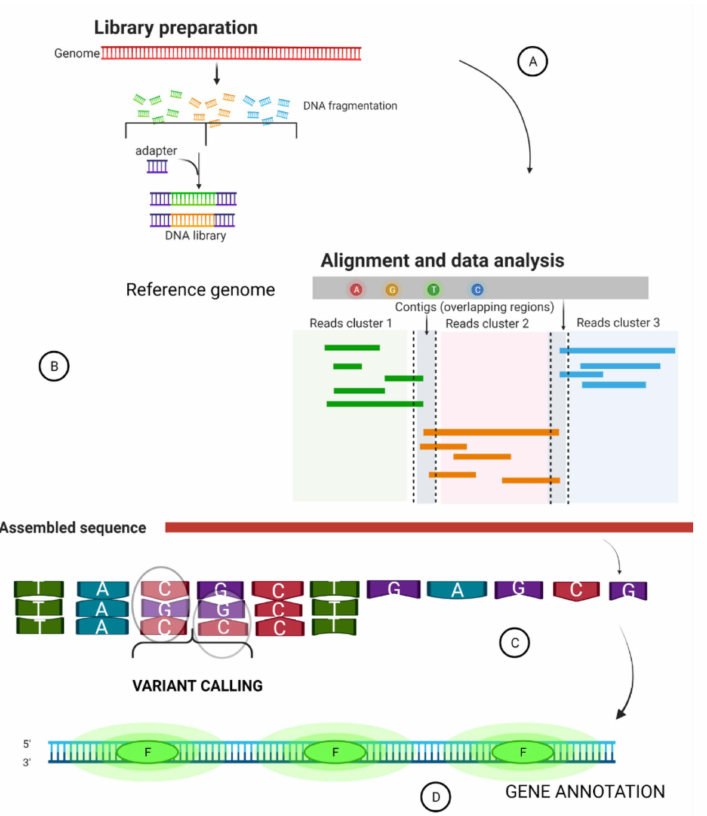
Figure 1. Diagram of a whole genome sequence pipeline. ( A ) Shows process of library preparation. ( B ) Speaks to mapping nucleotide sequence to a reference genome. ( C ) shows detection and calling of variants (SNP). ( D ) Gene annotation: identification of functional elements across the genome. The letters represent functional